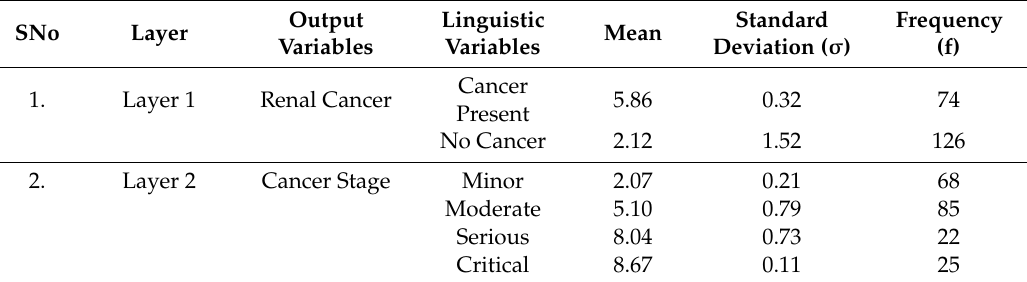
Table 6. Parameters of